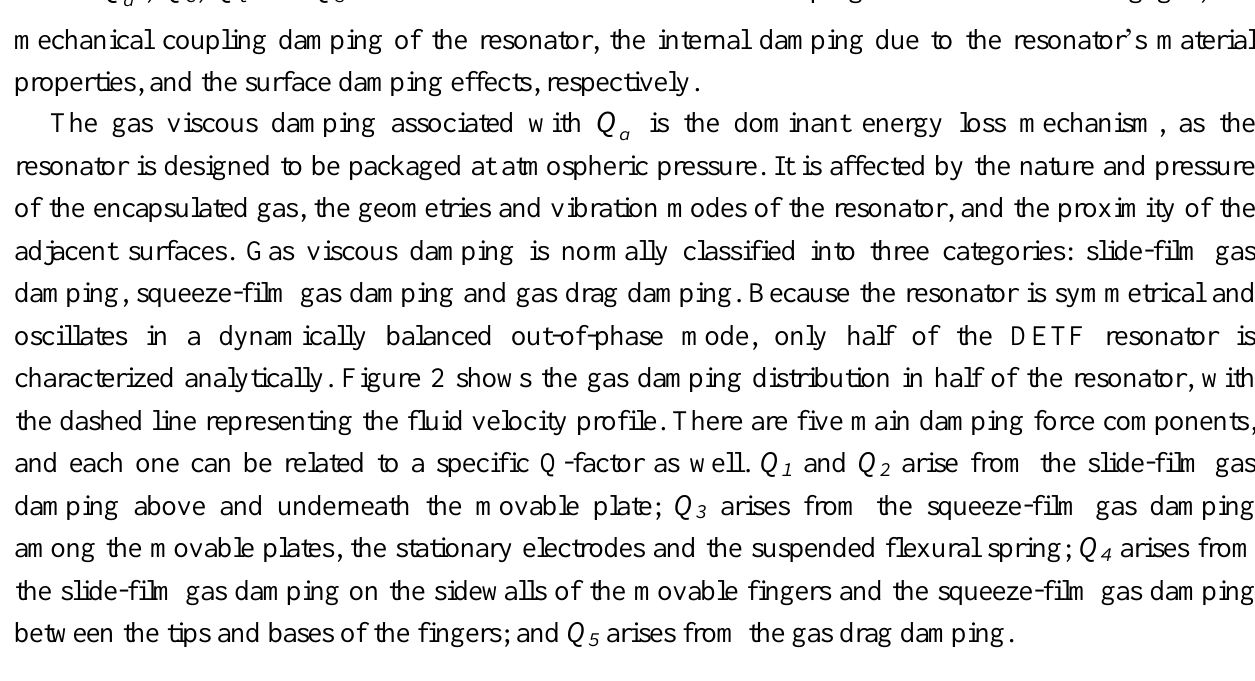
Figure 2. The gas damping distribution in half of the DETF